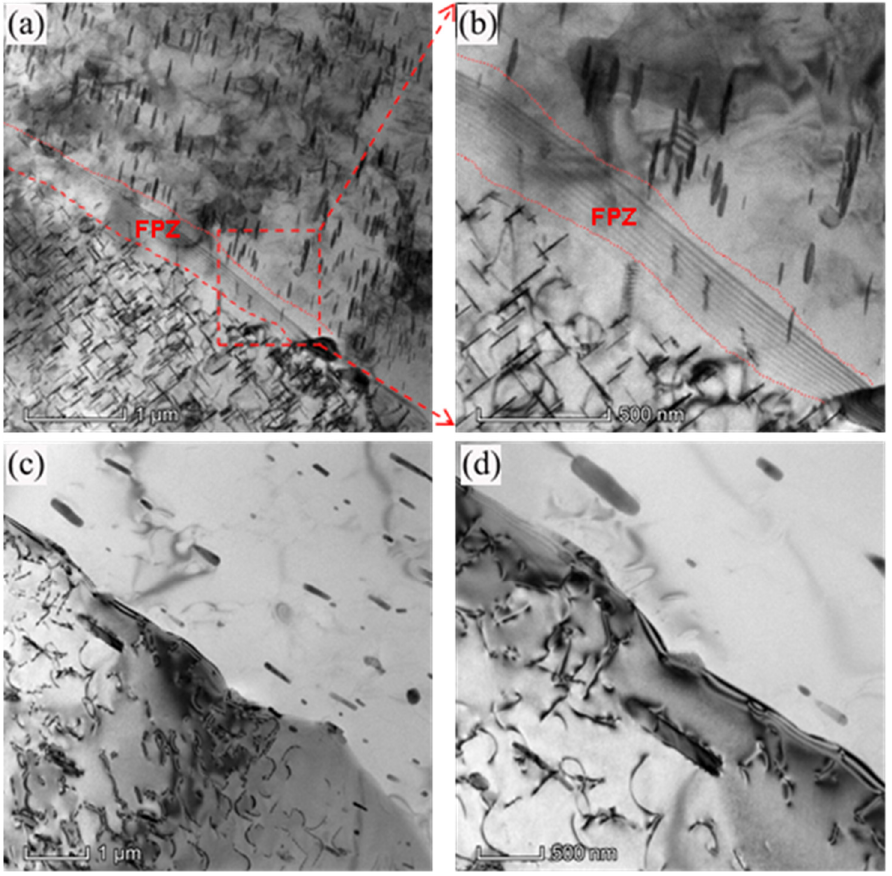
Figure 5. Transmission electron microscopy micrograph of the lowest hardness in the joint: position 2 of 2A5R joint ( a , b ) and position 4 of 5A2R joint ( c , d ) from Figure 2c,d.